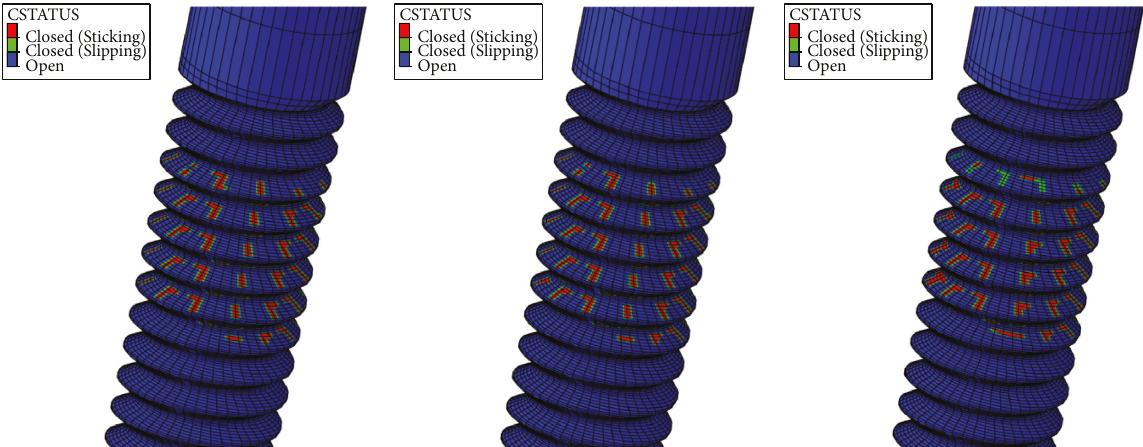
Figure 18: Time-varying graph of thread contact state under impact load (the loose bolt to 300N preload under 1.5kN impact load on the